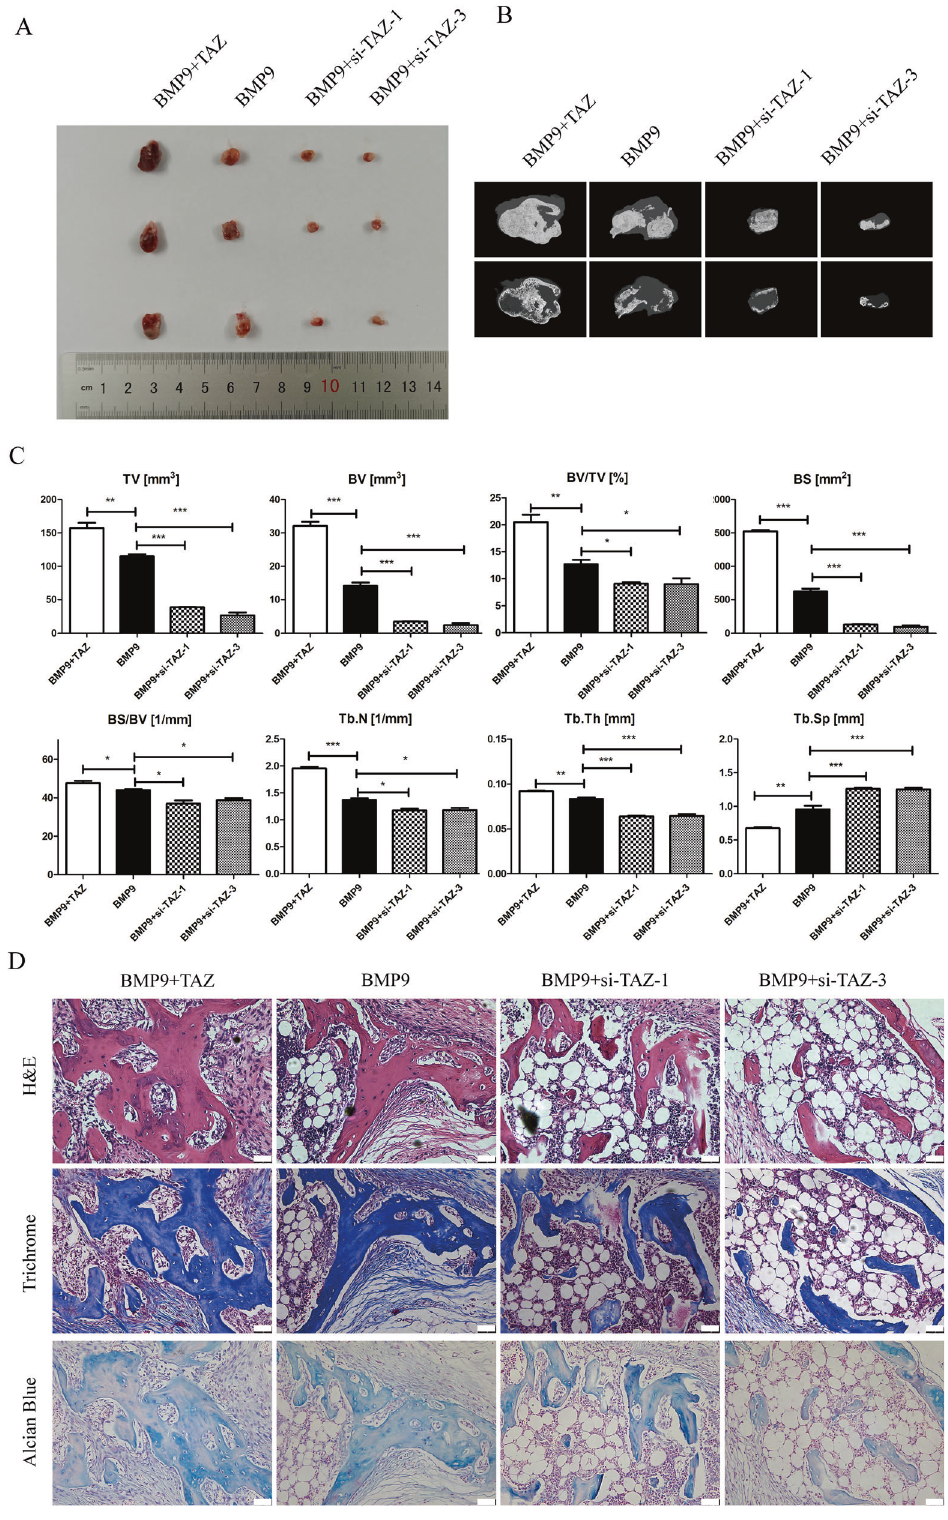
Fig. 4 The effect of TAZ on BMP9-induced ectopic bone formation in MSCs and MMCs. A The general observation of the subcutaneous mass of ectopic osteogenesis in nude mice. B Subcutaneous osteoblast mass for micro-CT scanning to get a representative reconstructed 3D image. C Quantitative analysis of bone tissue and the values of TV, BV, BV/TV, BS, BS/BV, Tb.N, Tb.Th, and Tb.Sp were analyzed. D H&E staining and Masson ’ s Trichrome staining and Alcian Blue staining to detect the formation of trabecular bone, bone matrix, and cartilage matrix under the treatment as shown. The data were shown as mean ± SD for three separated experiments. ( *P < 0.05 , **P < 0.01 , ***P < 0.001). TV tissue volume, BV bone volume, BV/TV percent bone volume, BS bone surface, BS/BV bone surface/volume ratio, Tb.N trabecular number, Tb.Th trabecular thickness, Tb.Sp trabecular